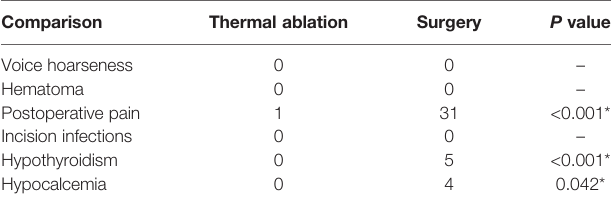
TABLE 3 | Comparison of the complications of the thermal ablation group and surgery group. Comparison Thermal ablation Surgery P